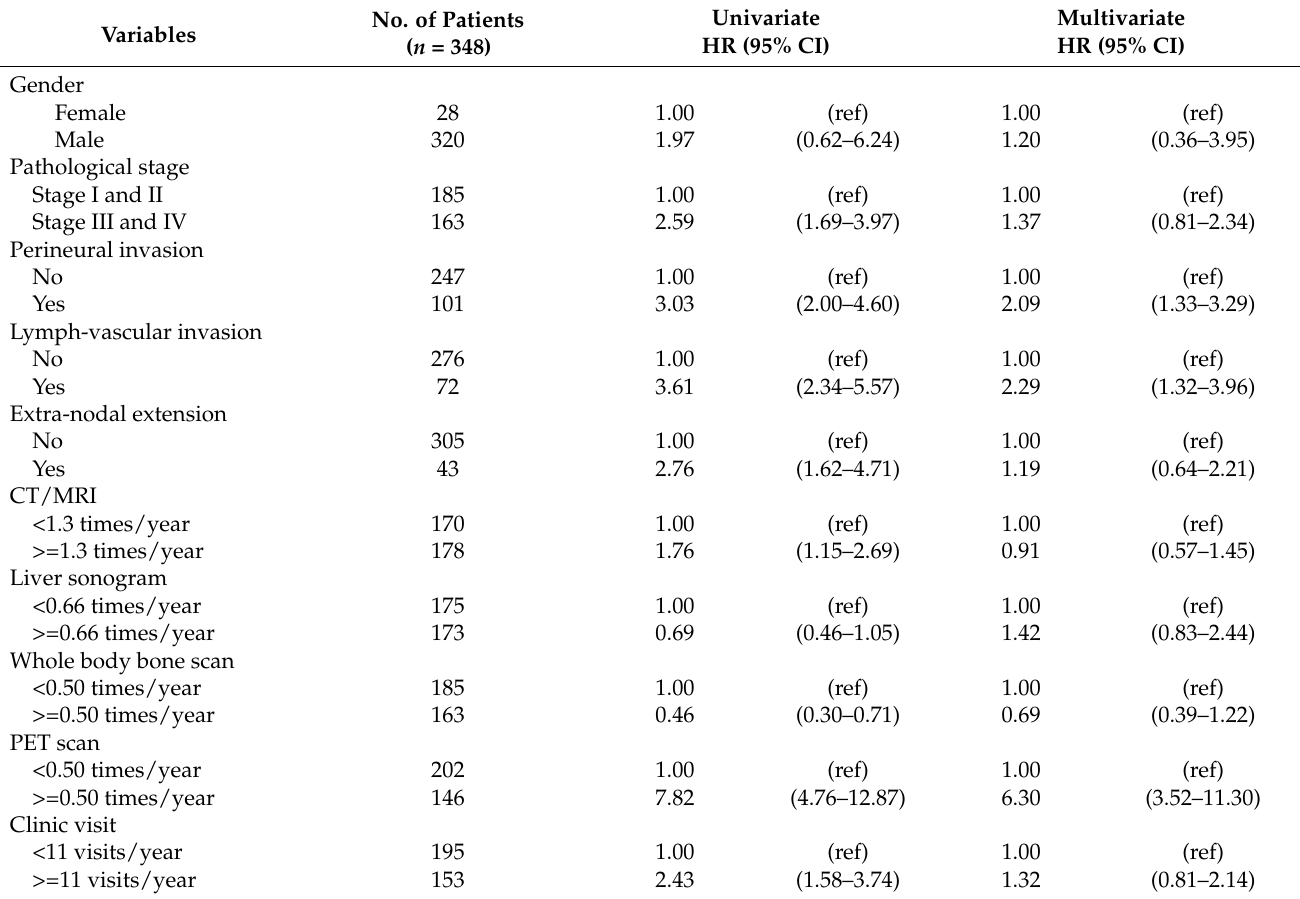
Table 6. Factors associated with disease-specific survival in younger oral cavity cancer